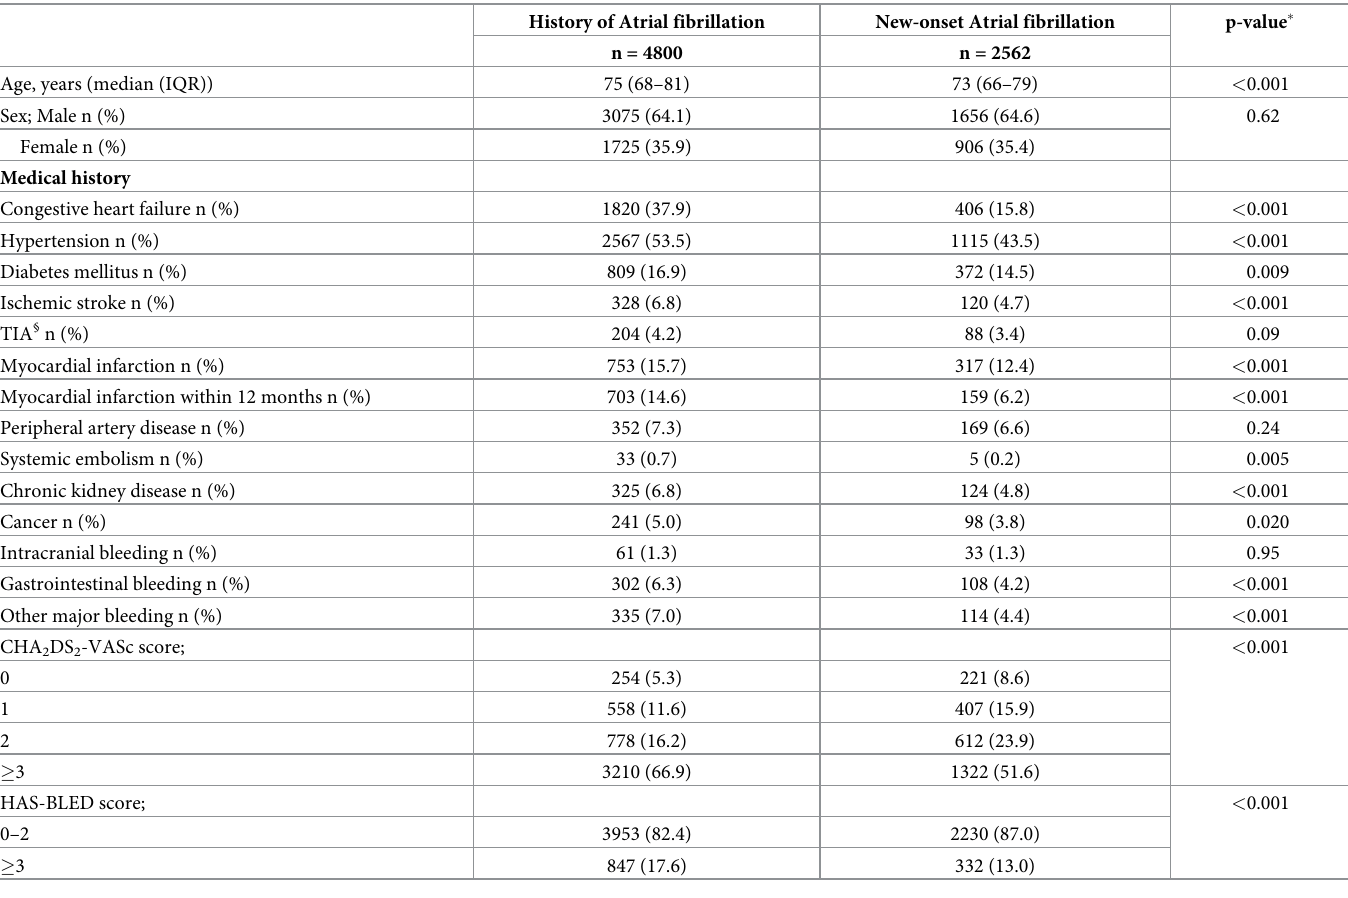
Table 1. Baseline characteristics of the patients with a history and new onset atrial